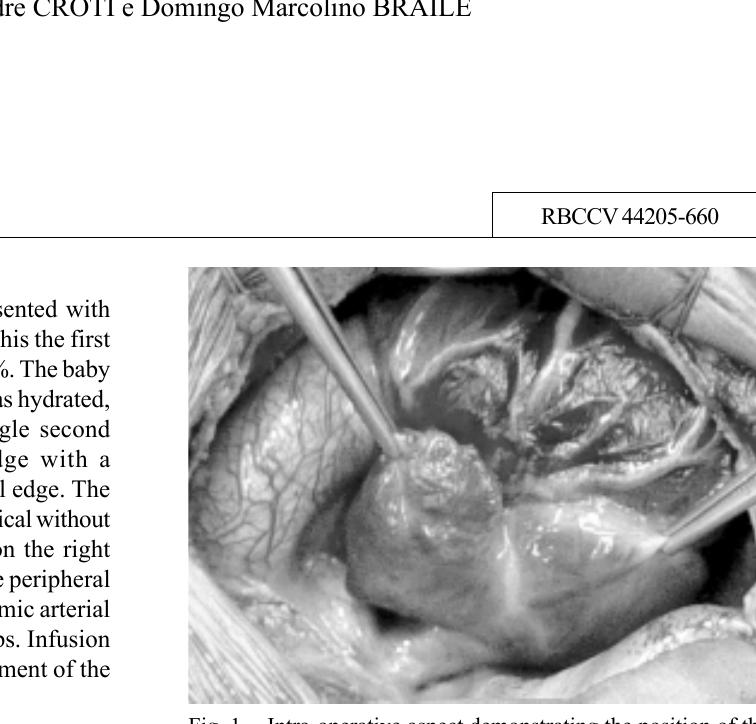
Fig. 1 - Intra-operative aspect demonstrating the position of the two atria (right atrial isomerism